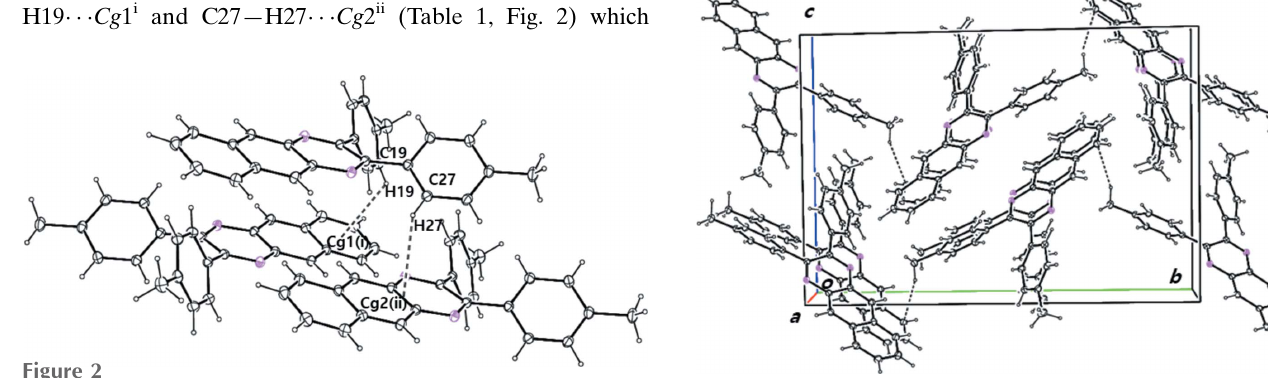
Figure 3 Crystal packing of the title compound, showing molecules linked by intermolecular C—H (cid:2)(cid:2)(cid:2) (cid:2) bonds (dashed lines).